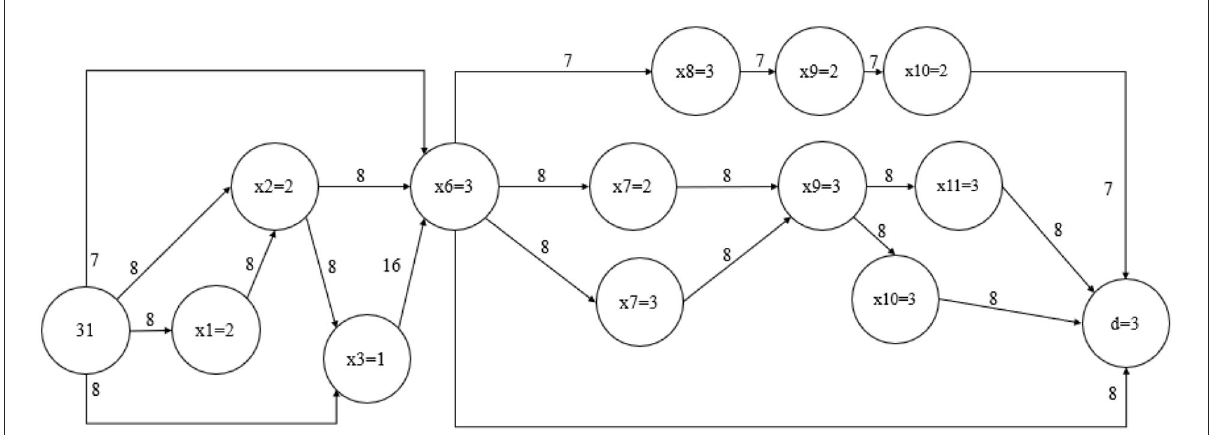
FIGURE4 Decision flow graph and rule-set of high intention to use GMFs class. x1 = 2 means that consumer is female; x2 = 2 means that consumer’s age is from 30 to 39; x3 = 1 means that consumer has diploma; x6 = 3 means that consumer’s perception of CSR is high; x7 = 2 means that consumer’s concerns about GMFs is medium; x7 = 3 means that consumer’s concerns about GMFs is high; x8 = 3 means that consumer’s promotion focus toward GMFs is high; x9 = 2 means that consumer’s prevention focus toward GMFs is medium; x9 = 3 means that consumer’s prevention focus toward GMFs is high; x10 = 2 means that consumer’s autonomy to choose GMFs is medium; x10 = 3 means that consumer’s autonomy to choose GMFs is high; x11 = 3 means that consumer’s competence to choose GMFs is high; d = 3 means that consumer’s intention to use GMFs is high.